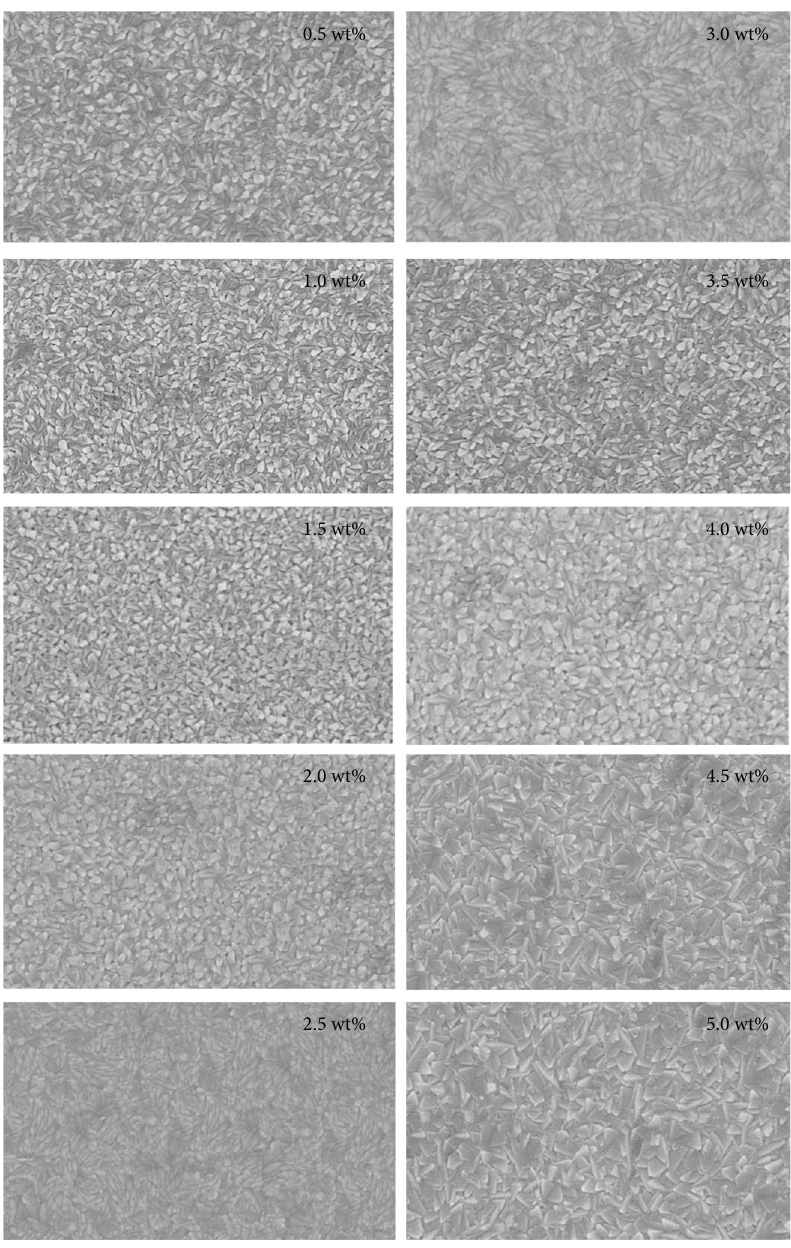
Figure 4: The SEM images of physical characteristics of ITiO fi lms of di ff erent doping concentrations from Ti-0.5wt% to